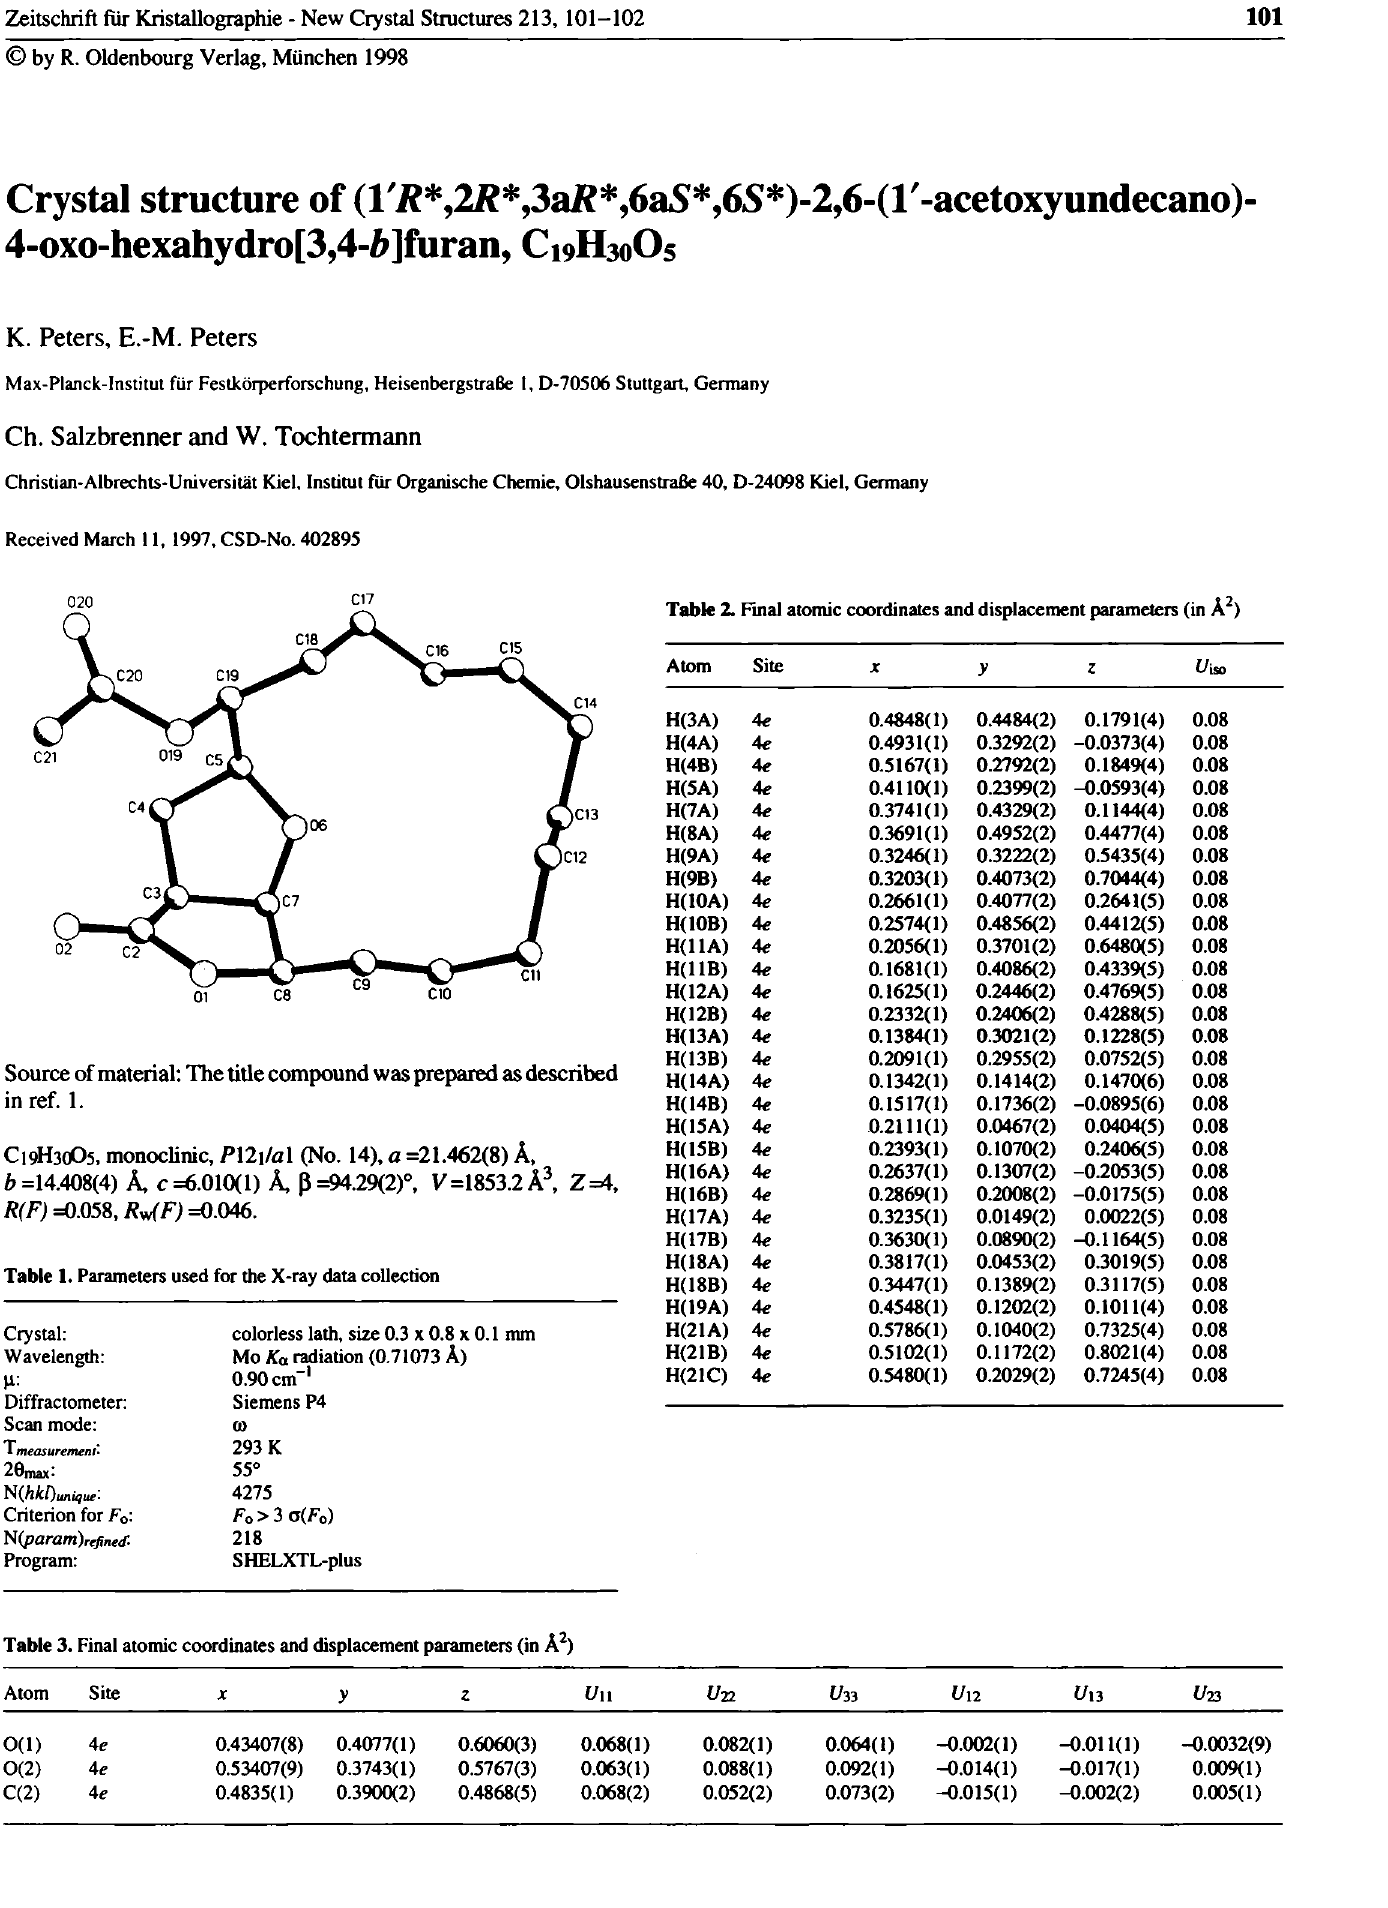
Table 1. Parameters used for the X-ray data collection